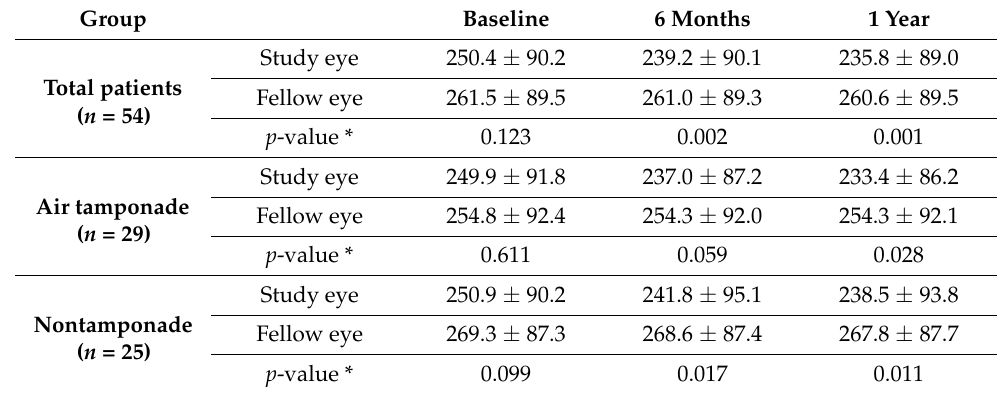
Table 3. Comparison of the thickness of the subfoveal choroidal between the study and fellow eyes in the air tamponade and nontamponade groups over 1 year. Group Baseline 6 Months 1 Year Total patients ( n =